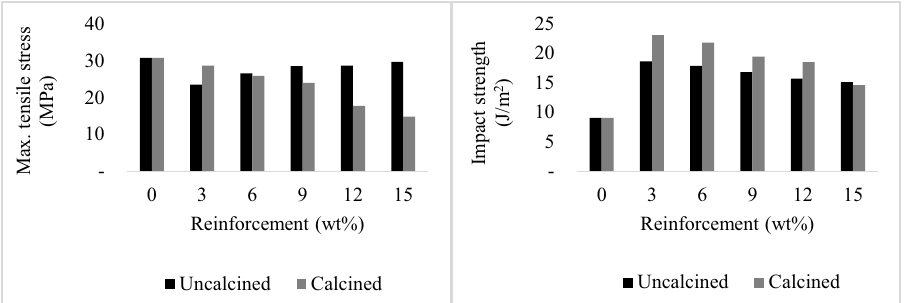
Figure 4: Comparison of tensile strength and impact energy values between raw ES particles and particles subjected to calcination. Figures were produced based on the data in [ 57 ]